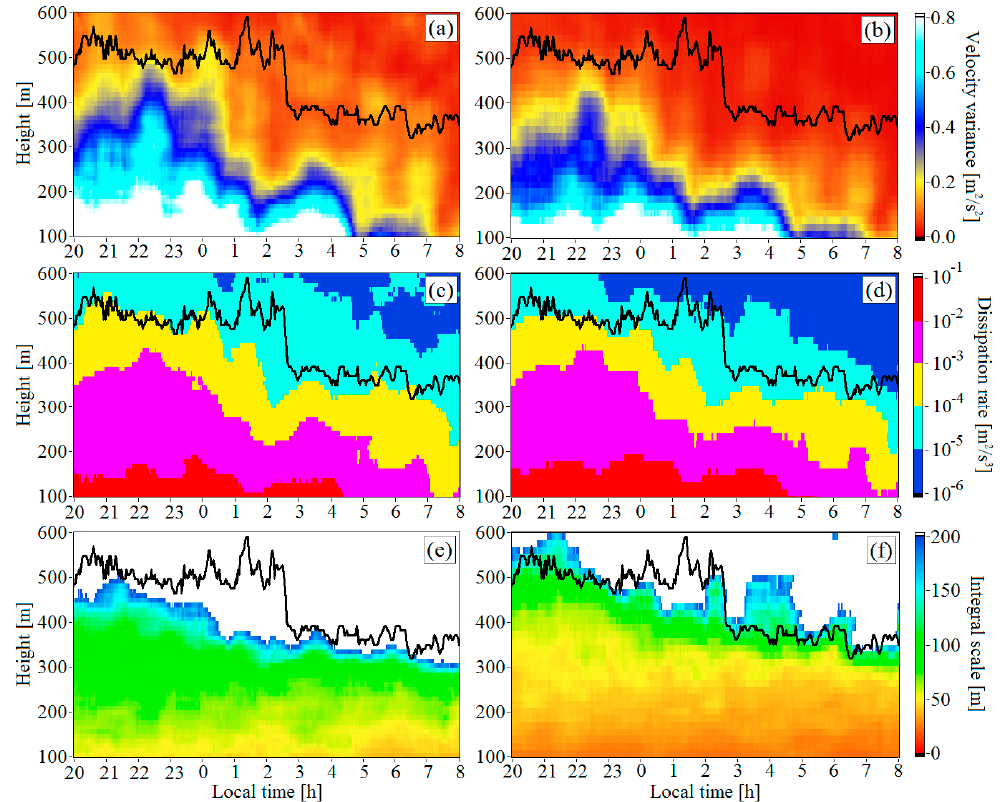
Figure 3. Height and time distributions of the ( a , b ) radial velocity variance, ( c , d ) turbulent energy dissipation rate, and ( e , f ) integral scale of turbulence obtained from lidar measurements at the Basic Experimental Observatory of the IAO on 23–24 July 2018 employing conical scanning at elevation angles of ( a , c , e ) 35.3° and ( b , d , f ) 60°. Black curves show the time profile of the height of maximal wind speed in the vertical distribution of the speed within low-level jet (LLJ).